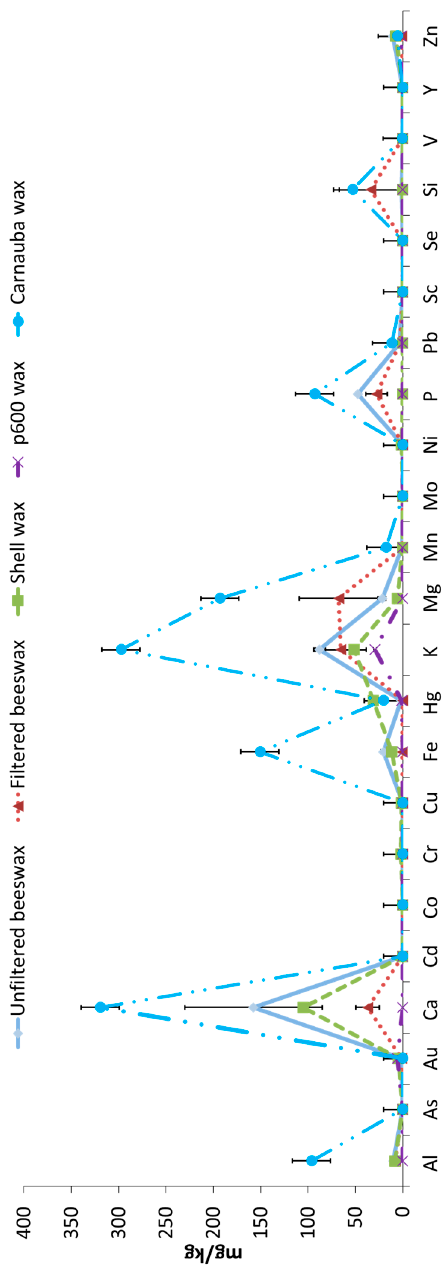
Figure 1. Chemical element profile of beeswax samples before and after the filtration process and of different waxes used for adulteration. Data (n = 3) shown as mean ± SEM for pre-filtered and post-filtered beeswax samples and a single measurement is shown for shell, p600 and carnauba wax.